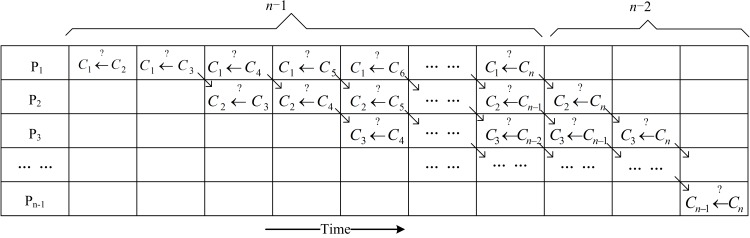
Pipeline of space-time diagram.